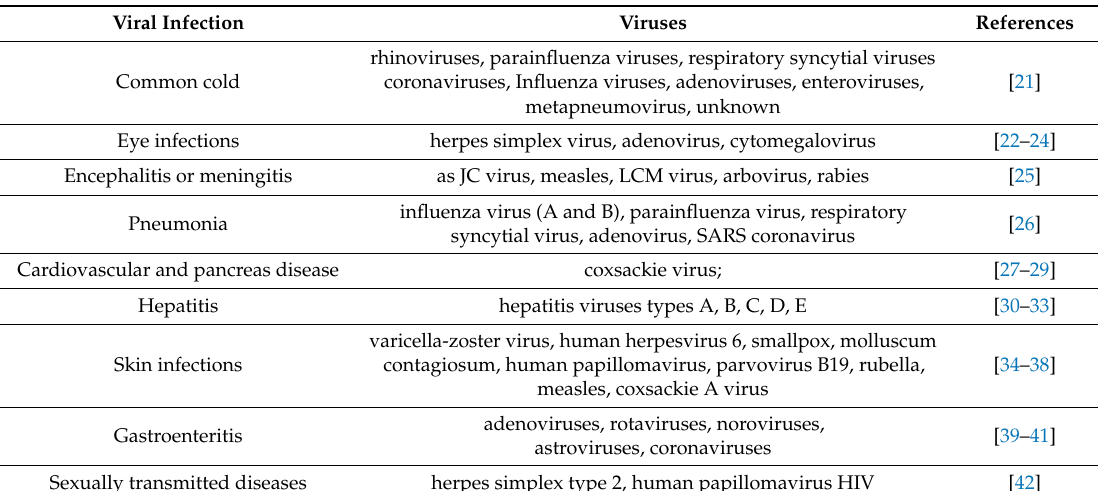
Table 1. Common viral